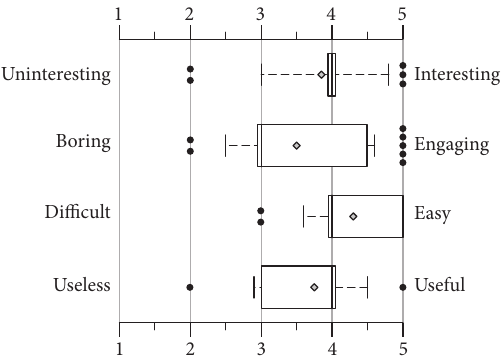
Figure 3: Assessment of the quality of the experience. Each boxplot shows the I, II, and III quartiles (box), the standard deviation (whiskers), outliers (black dots), and mean value (diamond).